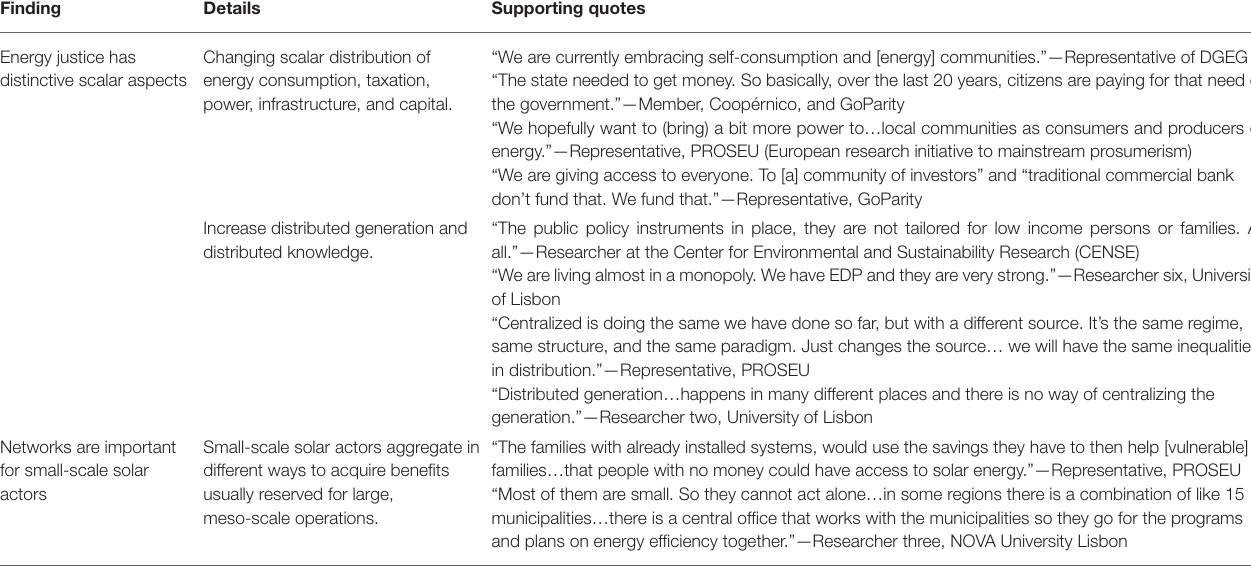
TABLE 2 | Main findings and quotes. Finding Details Supporting